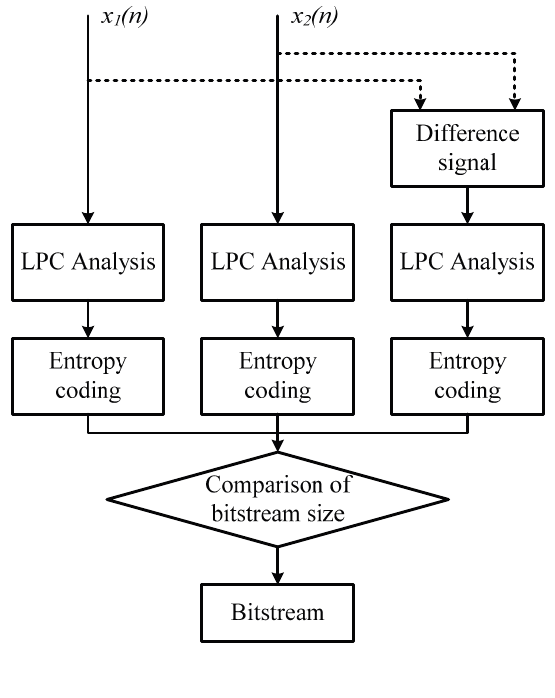
Figure 3. Joint-coding structure of MPEG-4 AL2S reference